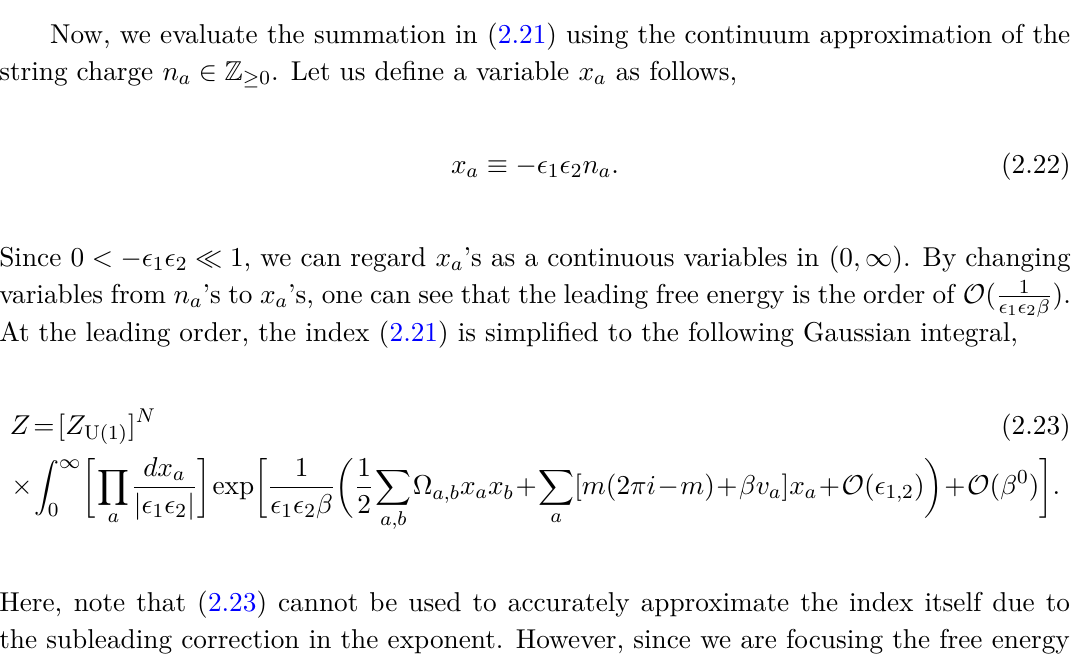
h i (cid:15) 1 (cid:15) 2 n 2 + m ( m − 2 πi ) n . Even though (cid:15) 1 , 2 and β are finite, the β β